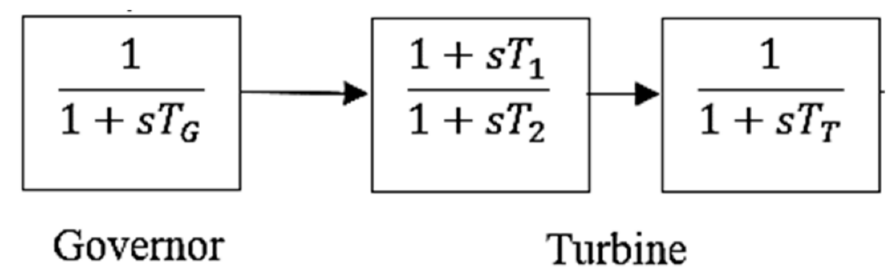
Figure 4. Governor-turbine transfer function.